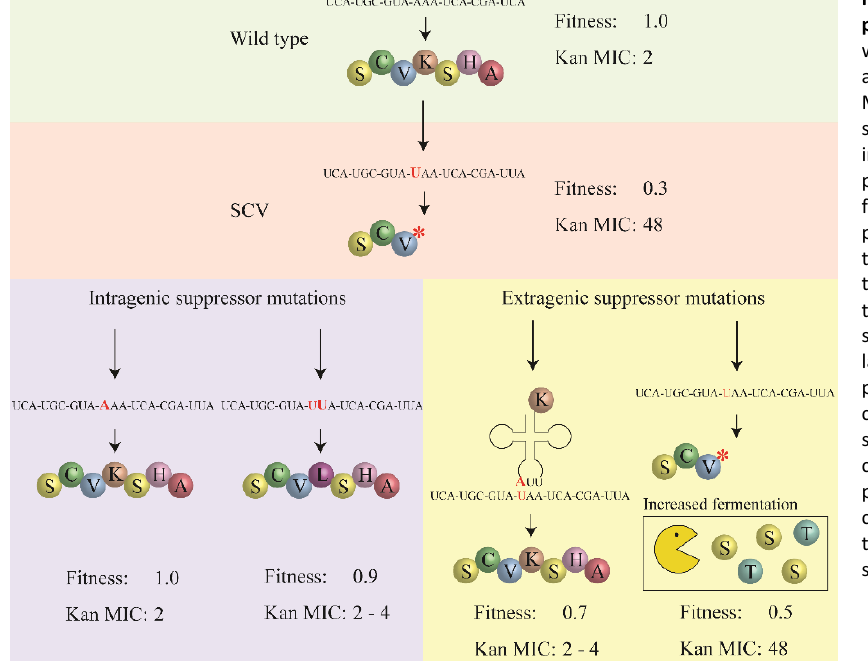
FIGURE 1: Evolutionary trajectories to sup- press an SCV phenotype. A hypothetical wild-type nucleotide and protein sequence associated with high relative fitness and low MIC for the aminoglycoside kanamycin is shown. In the SCV mutant shown there is an internal stop codon in gene involved in res- piration ( hem or men ), leading to decreased fitness and increased kanamycin MIC. Sup- pression can occur either by intragenic mu- tation (direct reversion or a second-site in- tragenic mutation) or by extragenic muta- tion (for example, a translational suppres- sor mutation, or a mutation in srrAB ).